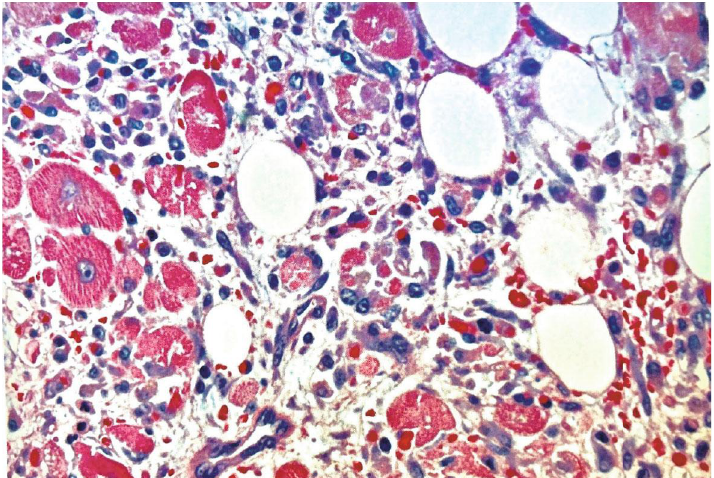
Figure 37: Myocardium in segmental arterial mediolysis. Apoptotic bodies composed of well-circumscribed densely eosinophilic cytoplasmic budding fragments are evident dispersed in newly formed granulation tissue composed of fi broblasts and capillaries. Hematoxylin & eosin × 200 (adapted from EC Cardiology 5.7 2018, online